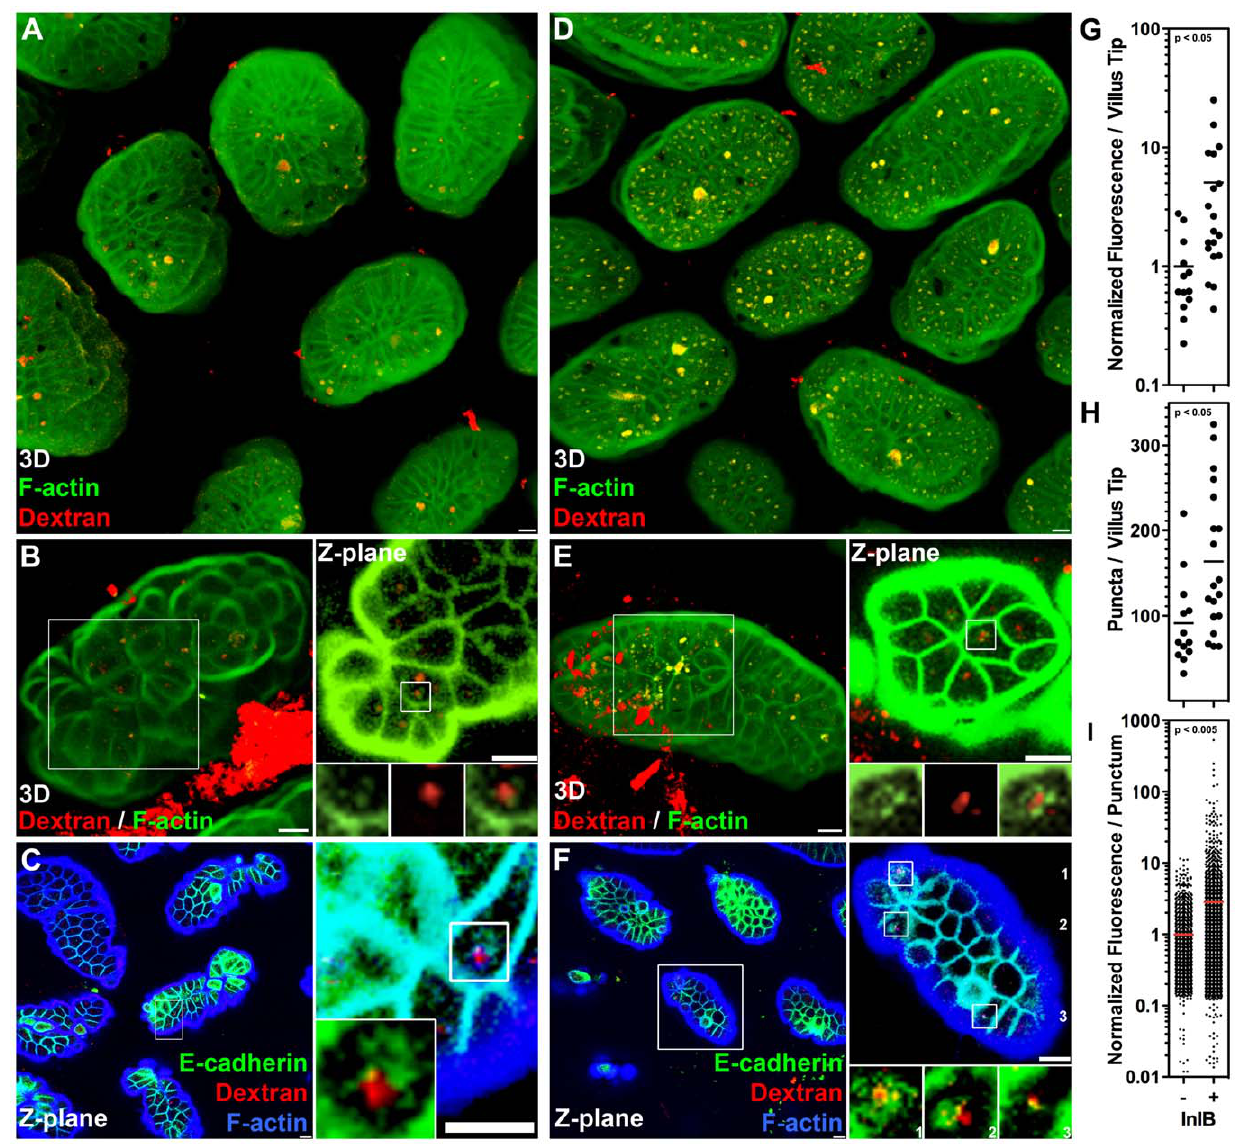
Figure 5. InlB enhances endocytosis at the intestinal villus tips. Fluorescent dextran, a fluid phase internalization marker, with or without InlB was incubated for 45 minutes in mouse ileal loops. (A) 3D confocal reconstructions of villus tips from an ileal loop incubated with dextran, red. Tissue was counterstained with phalloidin for F-actin, green. (B) Higher magnification villus tip from an ileal loop incubated with dextran, and a single Z- plane from inset showing puncta of intracellular dextran. (C) Single Z-plane from confocal image of villus tips from a loop incubated with dextran, red, and counterstained with anti-E-cadherin antibodies, green, and with phalloidin for F-actin, blue. Inset shows higher magnification of dextran puncta and intracellular E-cadherin. (D) 3D confocal reconstructions of villus tips from an ileal loop incubated with dextran, red, and InlB. Tissue was counterstained with phalloidin for F-actin, green. (E) Higher magnification villus tip from an ileal loop incubated with dextran, red, and InlB, and a single Z-plane from inset showing puncta of intracellular dextran. (F) Single Z-plane from confocal image of villus tips from a loop incubated with dextran, red, and InlB and counterstained with anti-E-cadherin antibodies, green, and phalloidin for F-actin, blue. Inset shows higher magnification of three separate dextran puncta and intracellular E-cadherin. Scale bars 10 m m. (G) Quantification of dextran fluorescence per villus tip from ileal loops incubated with dextran only ( 2 ) or dextran and InlB ( + ). (H) Quantification of dextran puncta per villus tip from ileal loops incubated with dextran only ( 2 ) or dextran and InlB ( + ). (I) Quantification of dextran fluorescence from all puncta analyzed from villus tips of ileal loops incubated with dextran only ( 2 ) or dextran and InlB ( + ).